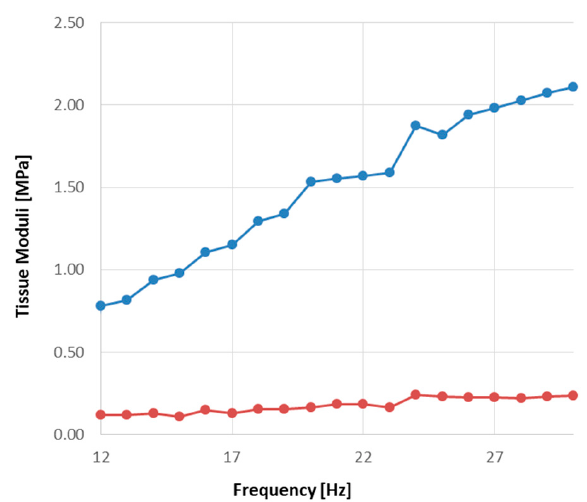
Figure 3. Dependence on frequency of the current elastic, E e , and loss modulus, E l , of an exemplary fragment of bovine ovarian tissue: ( • ,—) E e ; ( • ,—) E l .